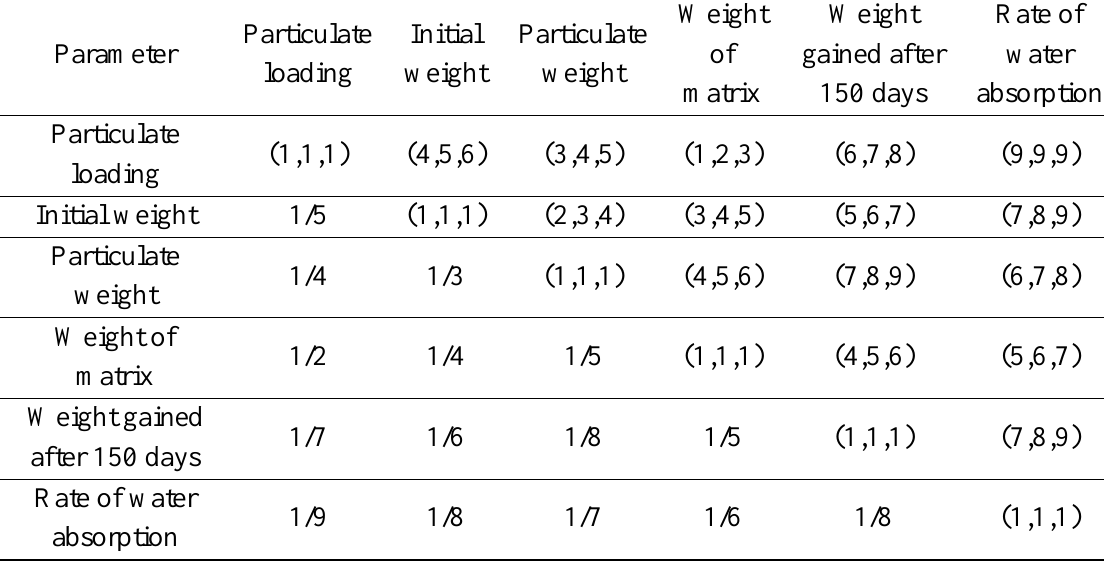
Table 2. Fuzzification pairwise comparison matrix for the cocoa pod husk composite.